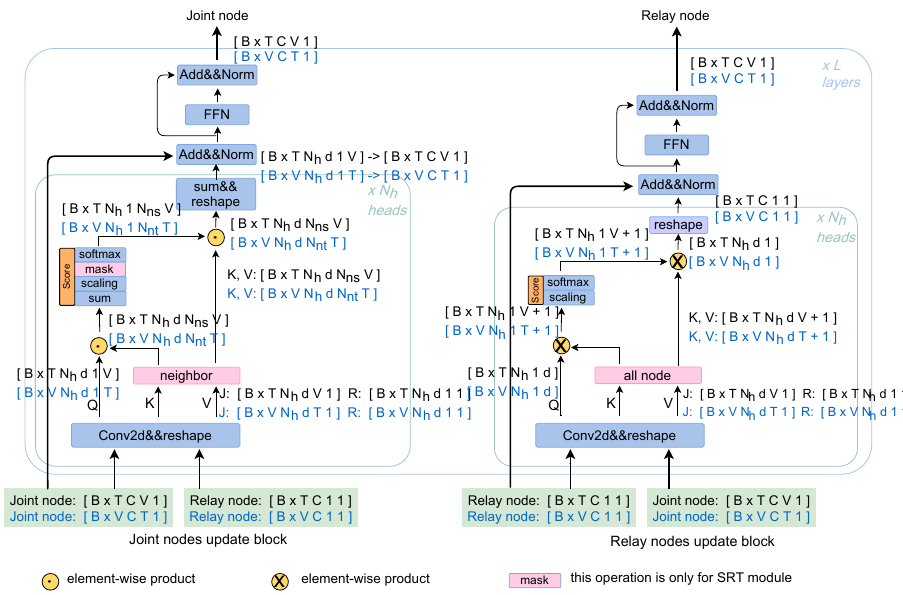
Figure 6. Illustration of the detail of the SRT module and TRT module. The tensor shapes with black font are for the SRT module and the blue are for the TRT module. It can be seen that the “mask” operation is only employed in SRT. In the SRT (TRT) module, the “neighbor” operation finds the adjacent nodes for each node according to Figures 4b and 5b